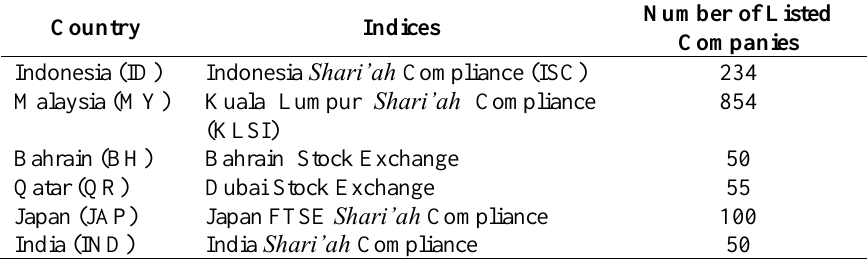
Table 1 Selected Country for Shari’ah Compliances